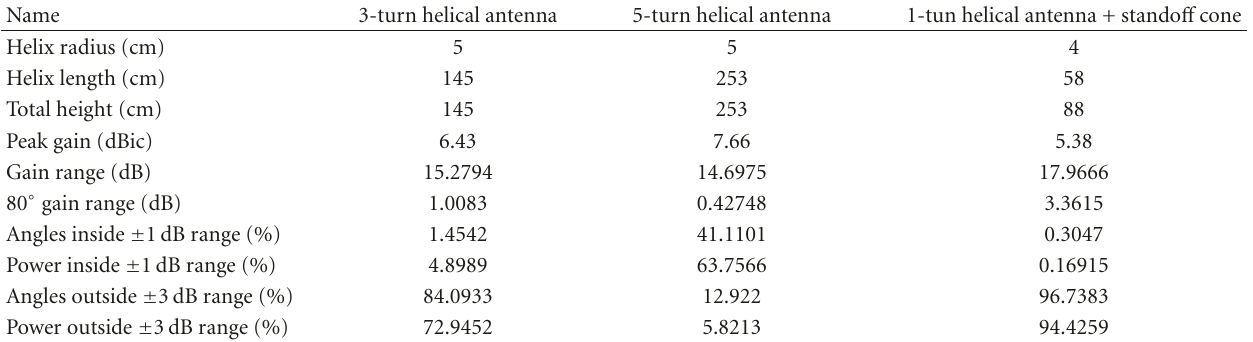
Table 3: Summary of figures of merit for antenna modification